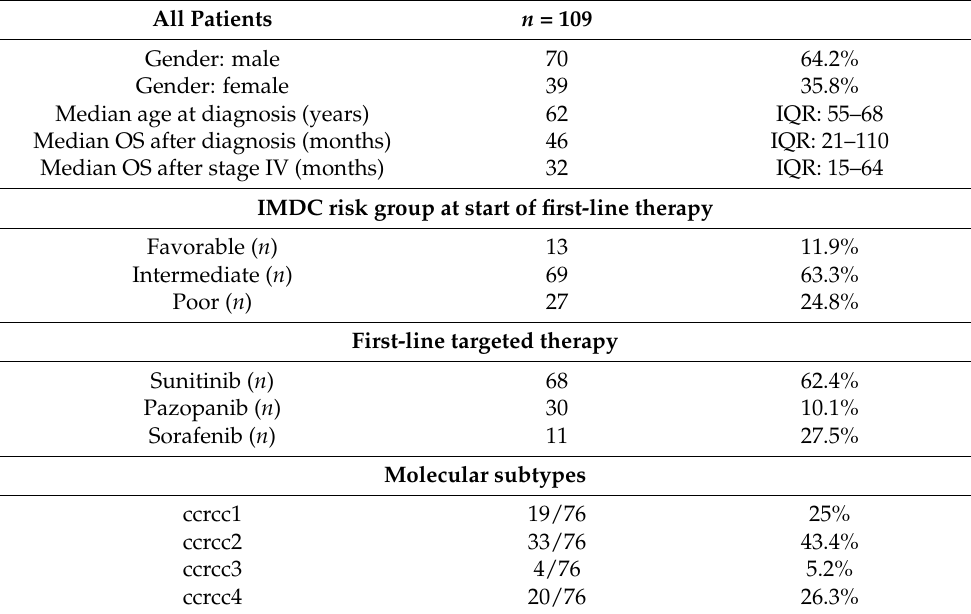
Table 1. Patient